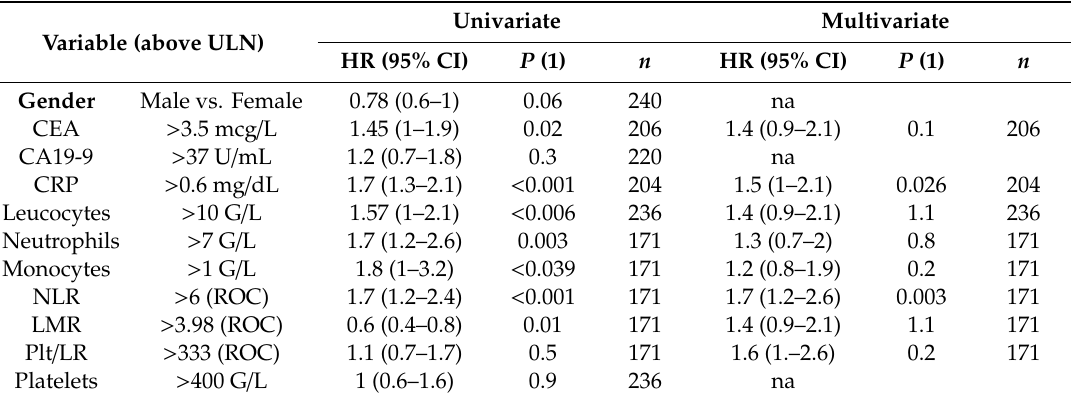
Table 2. Prognostic factors for overall